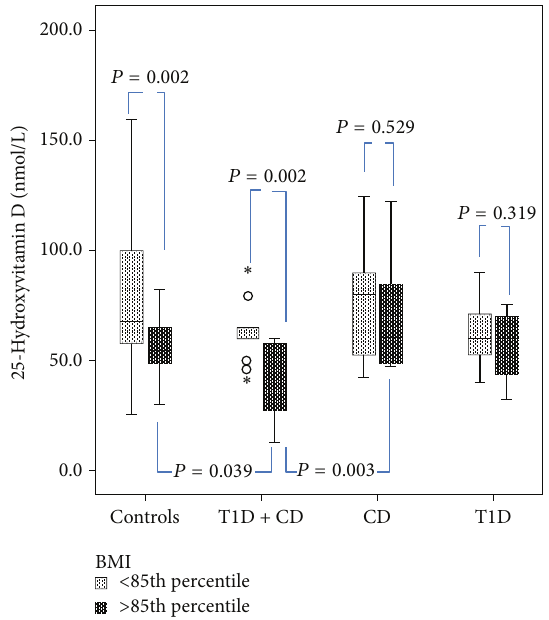
Figure 2: Box plots of the comparative analysis of the differences in serum 25-hydroxyvitamin D concentration of the control and study groups after stratification by body mass index criteria into normal- weight versus overweight/obese groups. The overweight/obese patients with T1D + CD ( 𝑛 = 5 ) had significantly lower 25(OH)D concentration compared to the overweight/obese controls ( 𝑛 = 28 ) ( 36.9 ± 20.7 nmol/L versus 55.6 ± 13.9 , 𝑃 = 0.039 ) and CD only ( 𝑛 = 8 ) ( 36.9 ± 20.7 versus 69.7 ± 28.6 , 𝑃 = 0.003 ). There was no significant difference in serum 25(OH)D concentration between the normal-weight